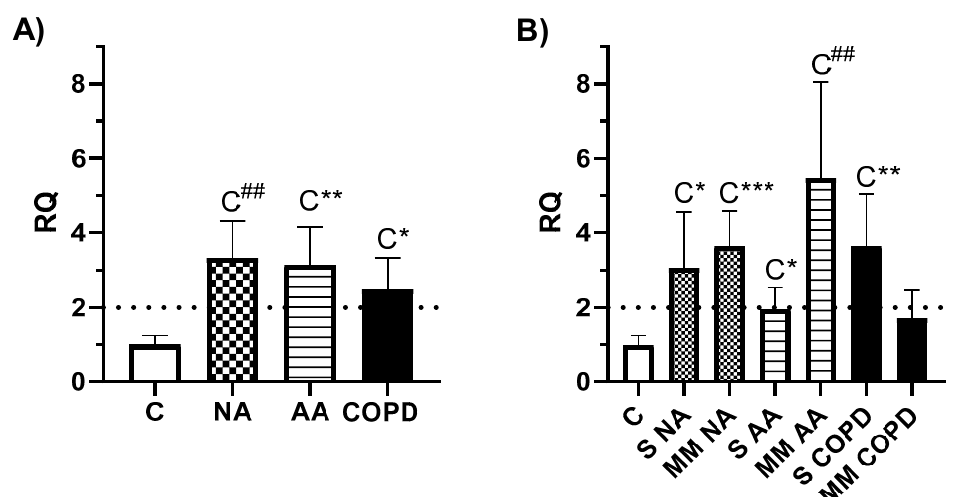
Figure 1. MSR1 gene expression according to clinical group, and severity of disease. C: Control ( n = 11), NA: Nonallergic Asthma ( n = 11), AA: Allergic Asthma ( n = 13), COPD ( n = 11), S: severe diagnosis; MM: moderate–mild diagnosis. ( A ) Gene expression results according to clinical group. The graphs represent the gene expression of MSR1 , with relative quantification (RQ) for the clinical groups compared to the C group. Error bars represent the standard error. The dotted line indicates an RQ value equal to 2. Statistically significant differences between C and the indicated disease group are shown as: C* ( p < 0.05), C** ( p < 0.005) and C ## ( p < 0.001). (B) Gene expression results according to the severity of disease. Statistically significant differences between C and the indicated disease group are shown as: C* ( p < 0.05), C** ( p < 0.005), C ## ( p < 0.001) and C*** ( p = 0.0005).